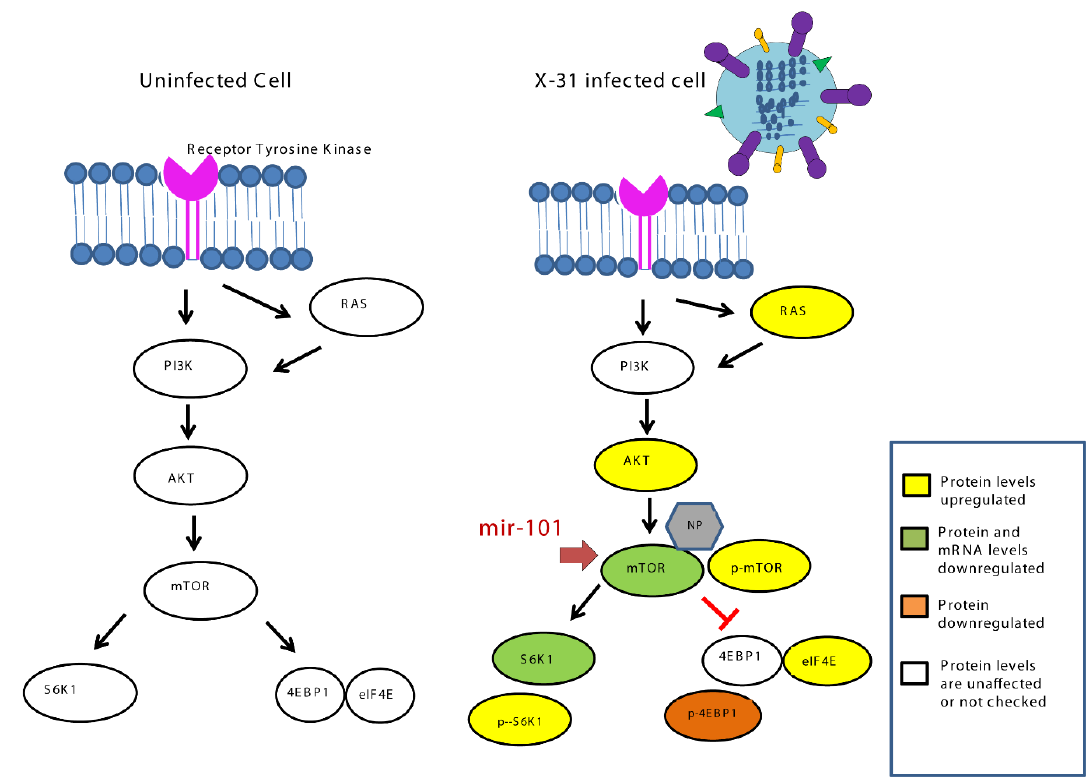
Figure 8. Schematic representation of mechanism for inhibition of IAV infection at later stage by upregulation of miR-101 which targets mTOR.